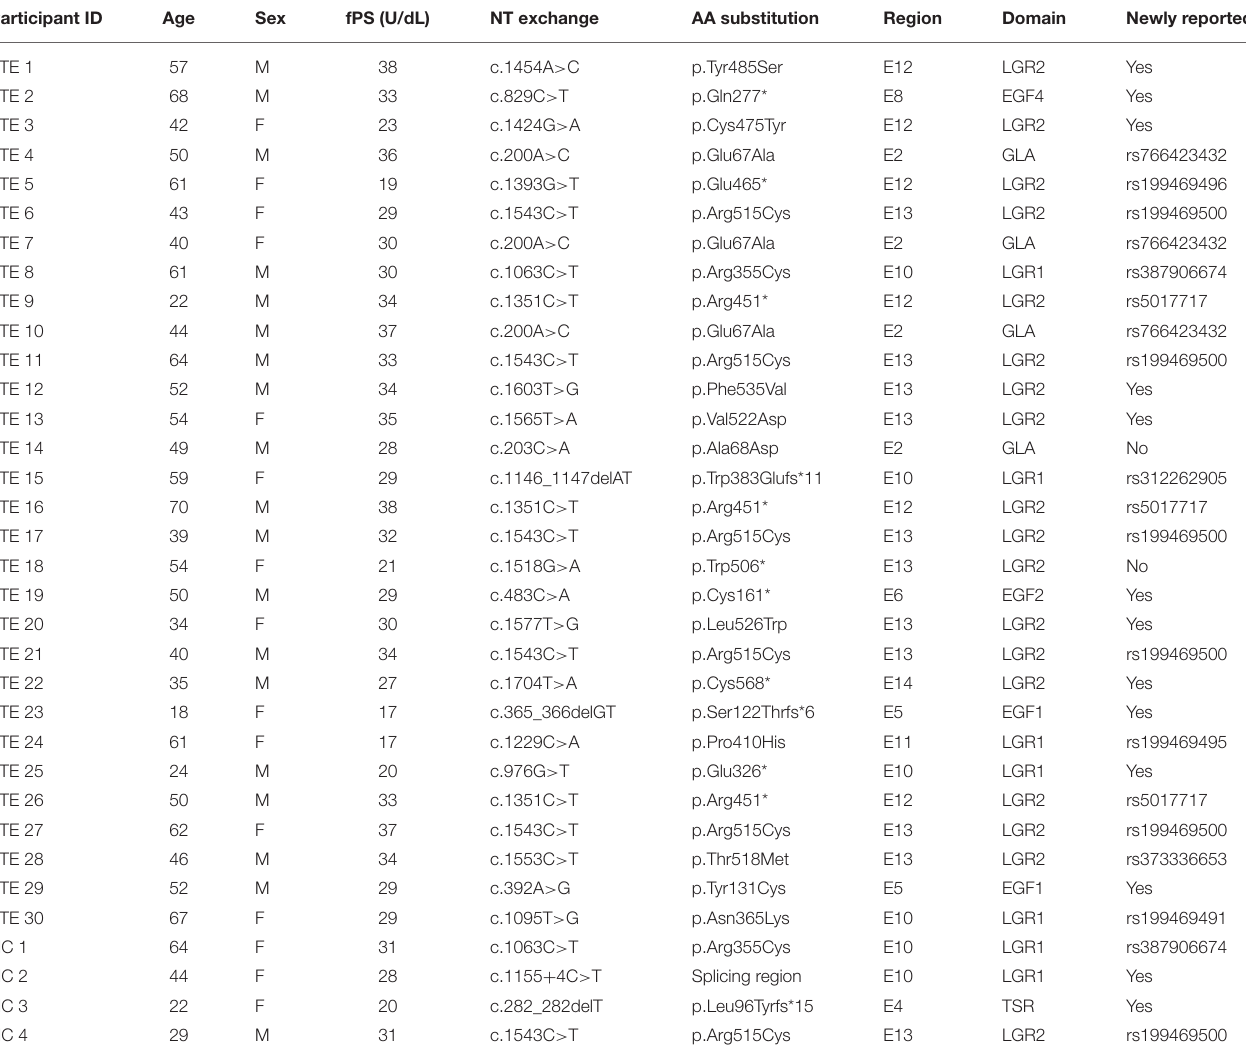
TABLE 2 | Molecular analysis of PROS1 in participants with free protein S below the 2.5 percentile. Participant